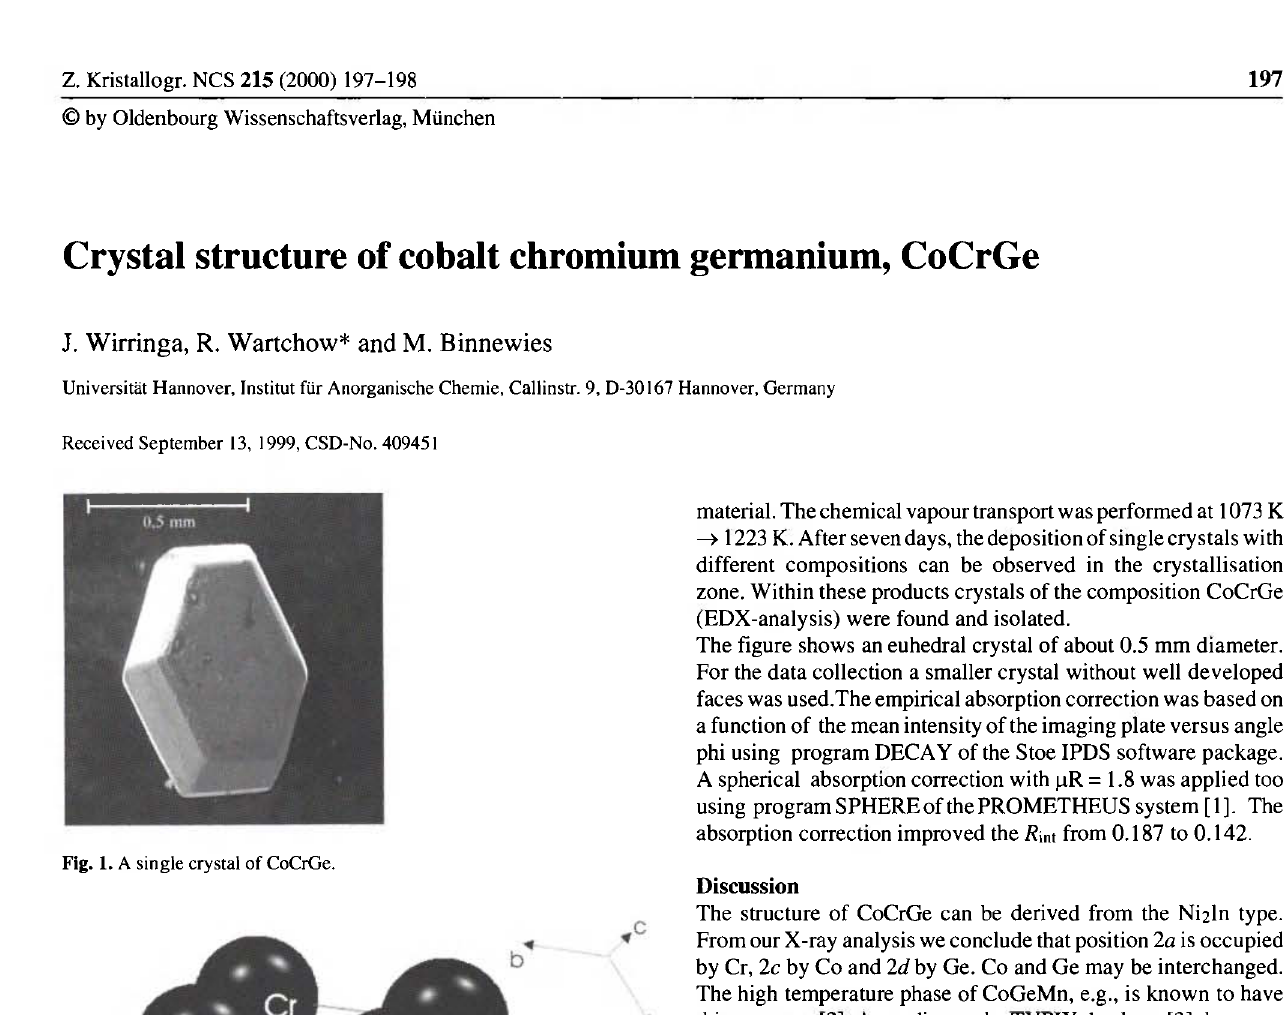
Fig. 2. Unit cell of CoCrGe.